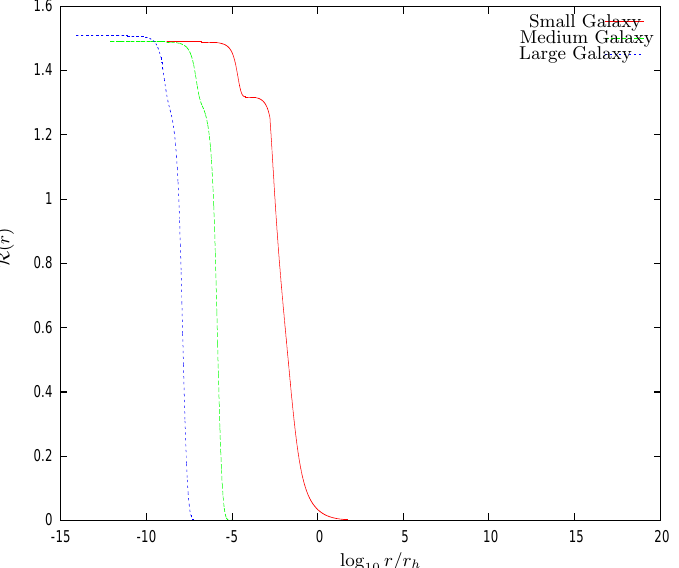
FIG. 5: The ratio of the particle de Broglie wavelength to the interparticle distance in the galaxy as a function of r for the three representative galaxy solutions with central SMBH: small galaxy (red), medium galaxy (green), and large galaxy (blue). For (cid:46) 1, the galaxy plus SMBH system is of a classical nature, while for (cid:38) 1, the system is quantum. The transition from the quantum to the classical regime occurs precisely at the same point r A where the chemical potential vanishes (see Figure 1), showing the consistency and power of our treatment. This point defines the transition from the quantum to the classical behavior.